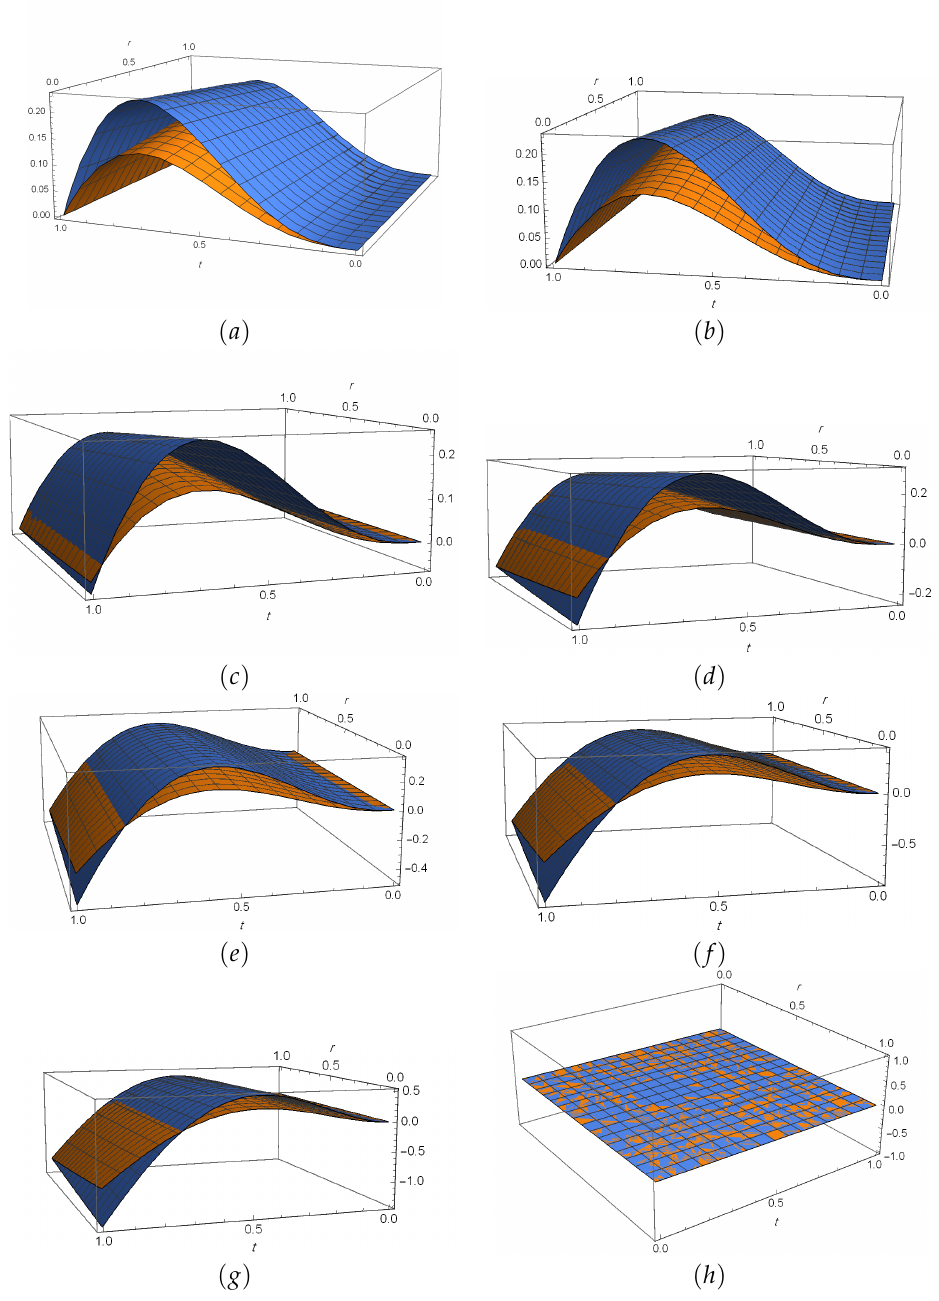
Figure 4. ( a ) The exact solution and ( b – h ) the Caputo gH-derivatives of the solution defined in Example 4 for α = 0,0.1,0.3,0.5,0.7,0.9,1,